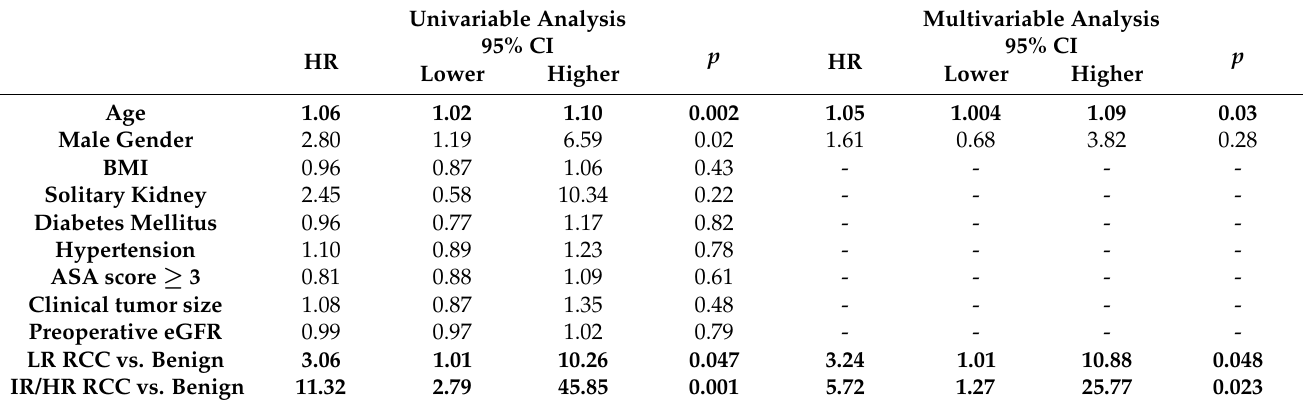
Table 3. Cox regression analyses to identify predictors of ROMeS nonachievement. Univariable